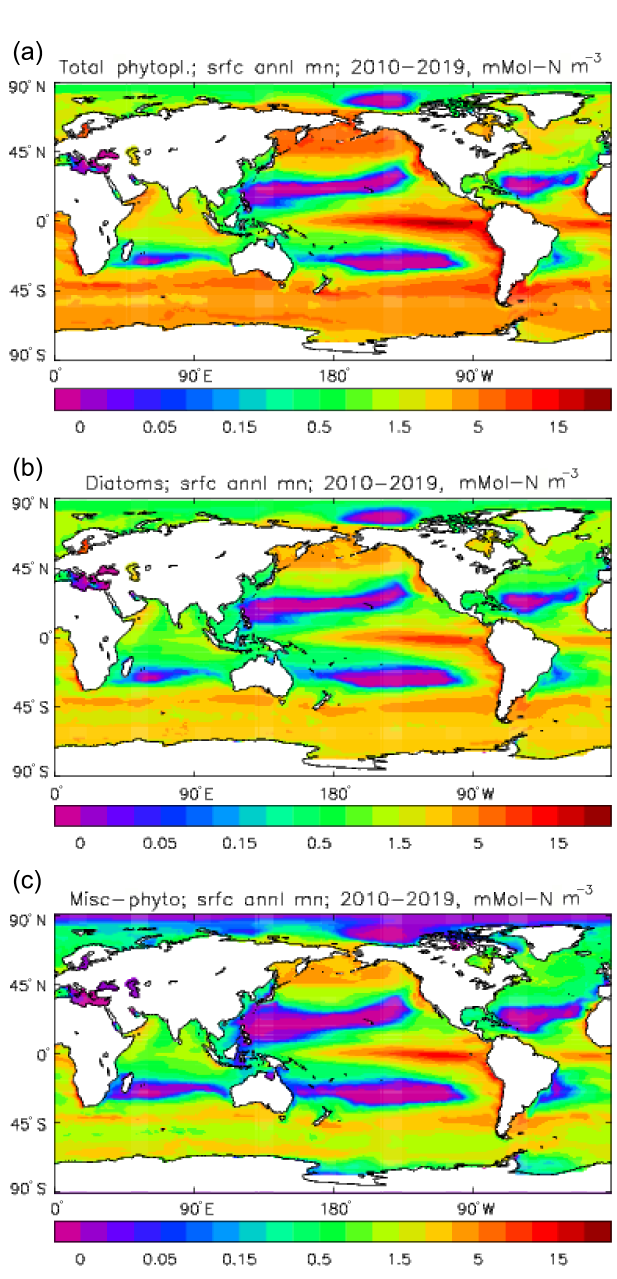
Figure 6. Phytoplankton surface biomass (mMolNm − 3 ), averaged over the model years 2010–2019: (a) total phytoplankton; (b) di- atoms; (c)